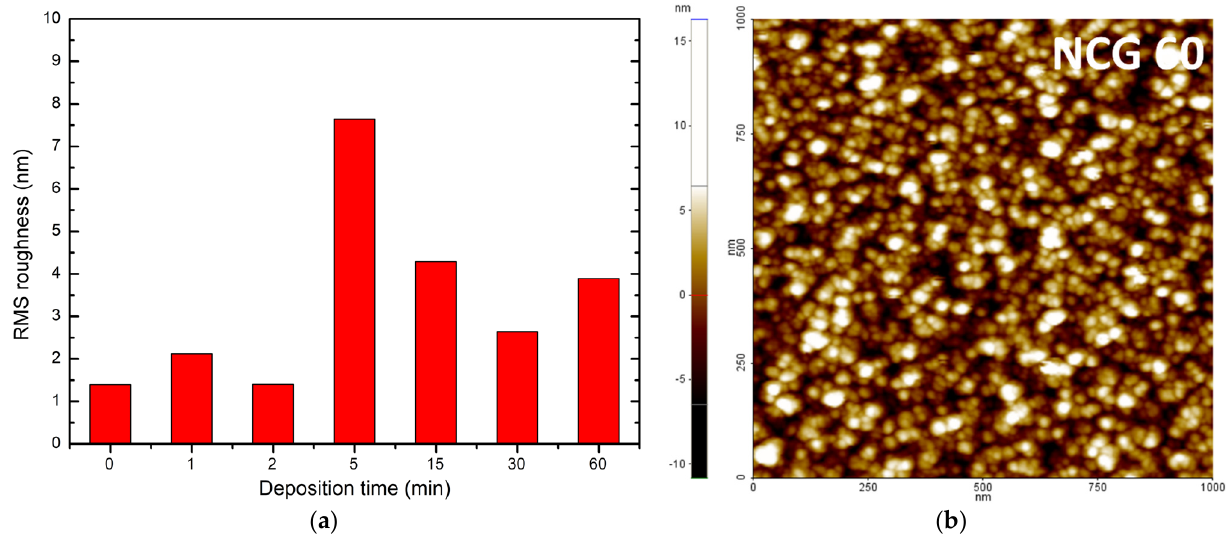
Figure 8. ( a ) The root mean square (RMS) roughness histogram of the NCG samples versus deposi- tion time (evaluated from the corresponding AFM images recorded at a 8 × 8 μ m 2 scale. ( b ) AFM time (evaluated from the corresponding AFM images recorded at a 8 × 8 µ m 2 scale. ( b ) AFM image image of NCG60 at a 1 × 1 μ m 2 scale. of NCG60 at a 1 × 1 µ m 2